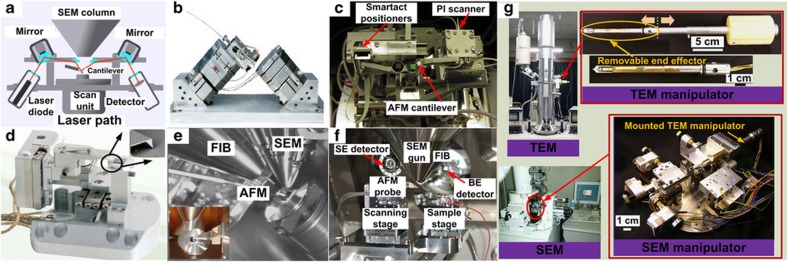
Hybrid system integration inside an SEM. (a) A hybrid AFM/SEM system based on laser beam deflection by DME-SPM. (b) AttoAFM/SEM system with a fiber-optic configuration by Attocube Systems AG. (c) A hybrid AFM/SEM system using self-sensing piezoresistive cantilevers. Adapted from Ref. 43. (d) An AFM system in dynamic mode for SEM integration by Trioptics. (e) 3TB4000 AFM/FIB/SEM system from Nanonics Imaging Ltd. (f) A hybrid AFM/FIB/SEM system. Adapted from Ref. 40. (g) A hybrid SEM and TEM manipulation system. Reprinted with permission from Ref. 13. AFM, atomic force microscope; FIB, focused ion beam; TEM, transmission electron microscope.